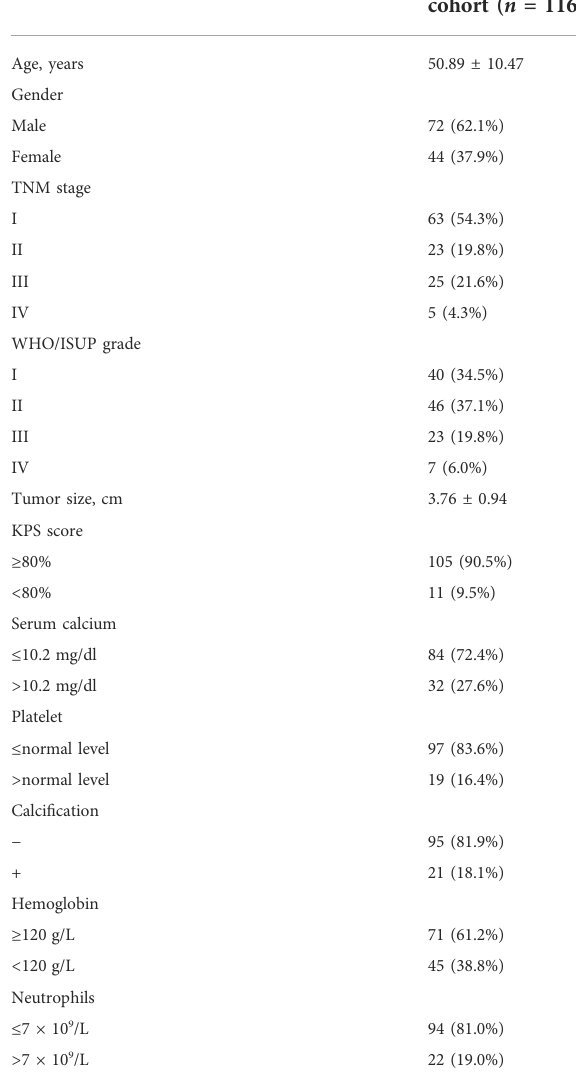
TABLE 1 Clinical characteristics for ccRCC patients in the FAHWMU